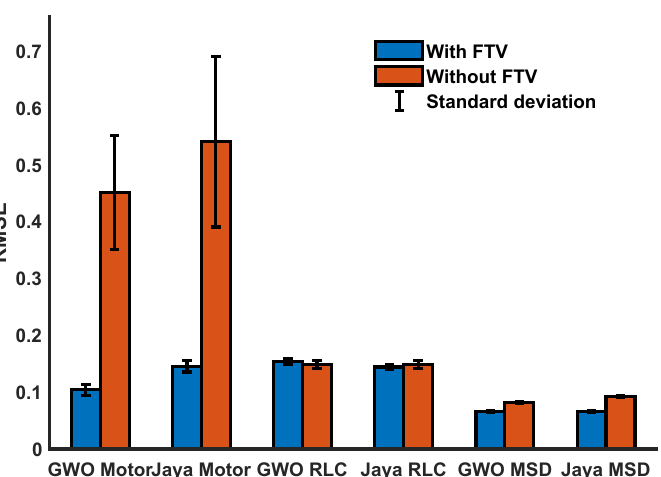
Figure 11. Comparison of the average values of the RMSE and the standard deviation for a set of ten simulations for each type of system.